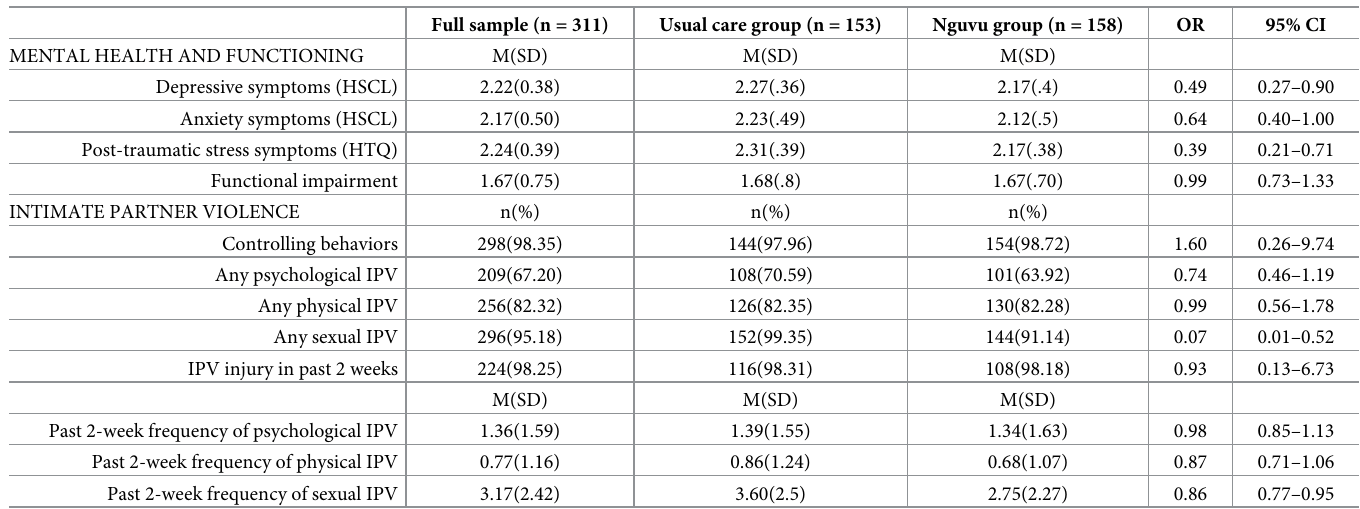
Table 3. Baseline clinical characteristics of sample (n =